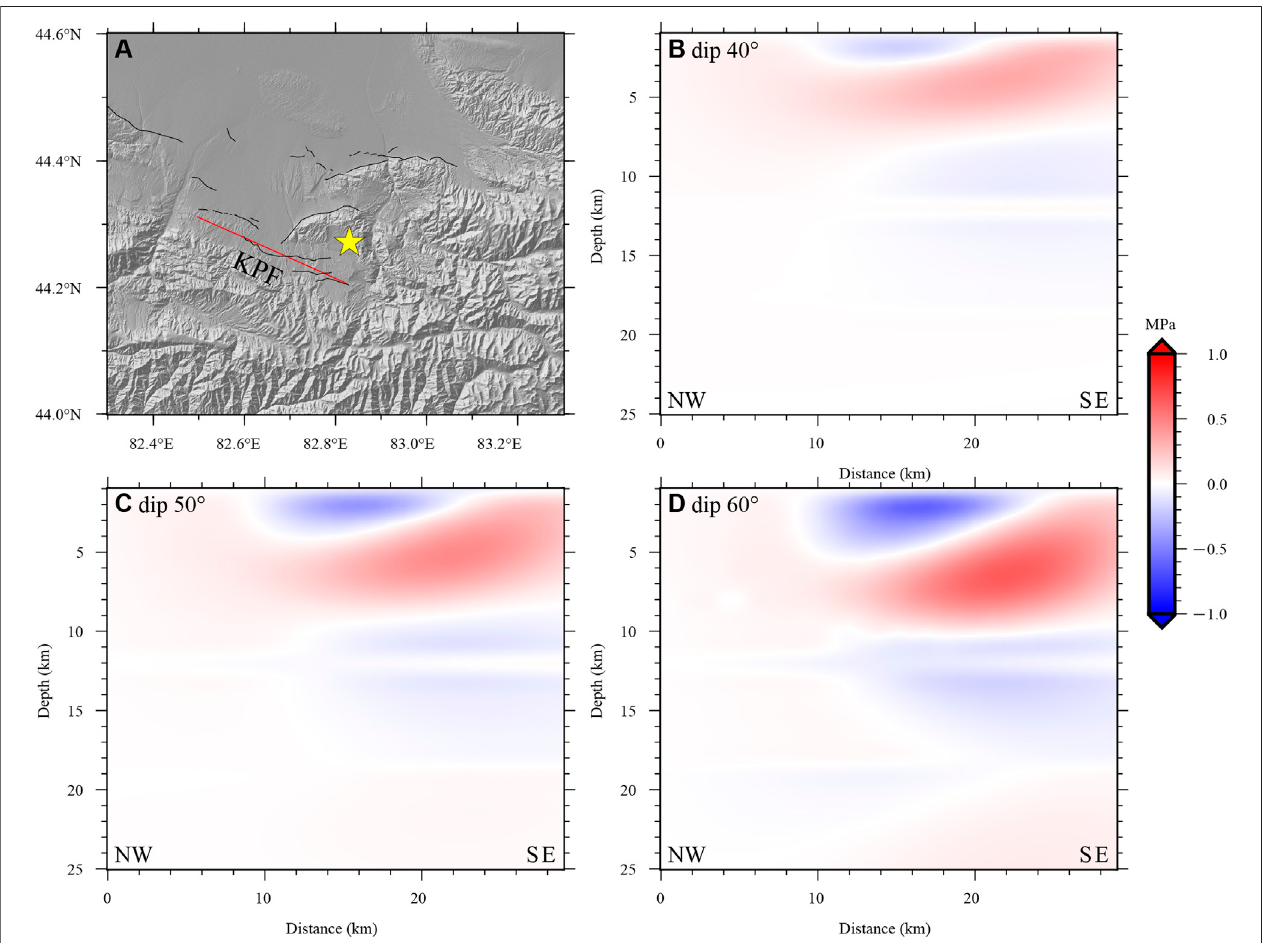
FIGURE6| CoseismicCoulombstresschangesofslipdistributionareconstrainedbyIPGPwiththereceivingfaultofKPF. (A) Theredlineissimpli fi edsurfacetrace of KPF. The epicenter of the mainshock is denoted by a yellow star. Coulomb stress changes on the fault plane in (B) dip angle 40 ° , (C) dip angle 50 ° , and (D) dip angle 60 ° .